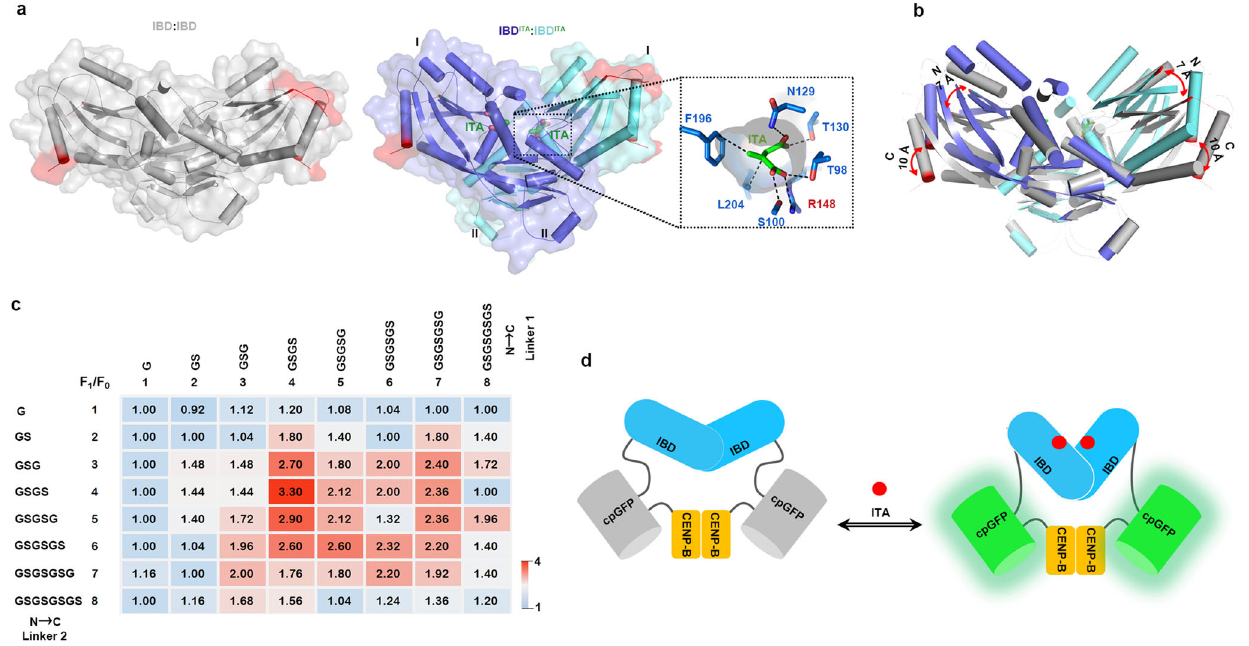
Fig. 1 | Constructing and optimizing itaconate biosensor. a Overall structure of IBD in apo (left, PDB: 7W08) or itaconate-bound (right, PDB: 7W07) state. The dottedlinescircumscribedthezoneofitaconatebindingpocketandthekeyamino acid residues that interact with itaconate were shown. b Overlay and structural alignment of IBD in apo (gray) and itaconate bound (green and blue) states. The largest structural rearrangement of each monomer is shown upon ligand binding. The N- and C-termini of the IBD are highlighted with the terminal residues in red andtheirassociateddisplacementfollowingligandbindingislabeledinangstroms. c Maxima values from emission peaks (monitored at 530nm after excitation at